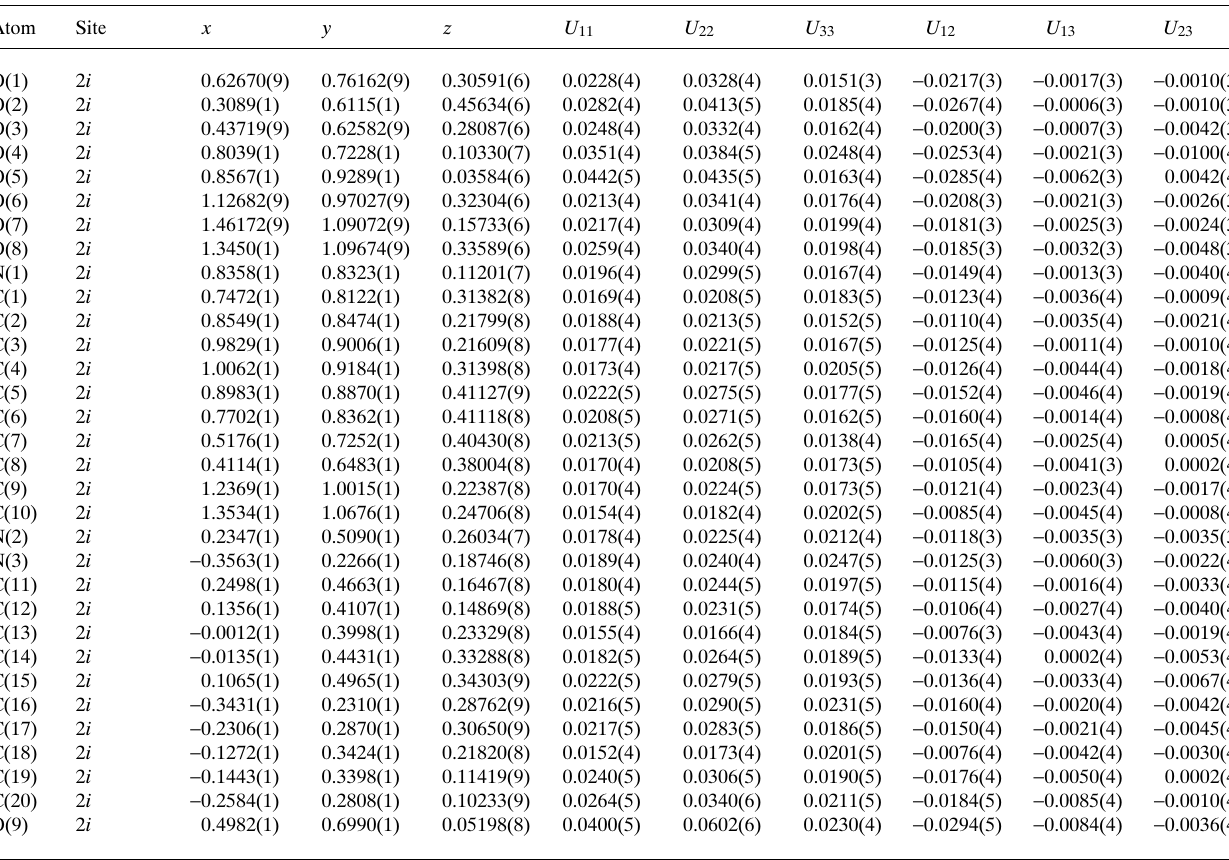
Table 3. Atomic coordinates and displacement parameters (in Å 2 ) .